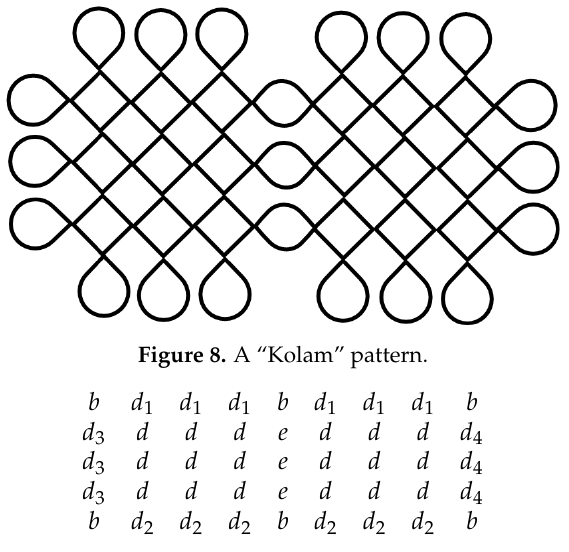
Figure 9. Array representing the “kolam” in Figure 8.